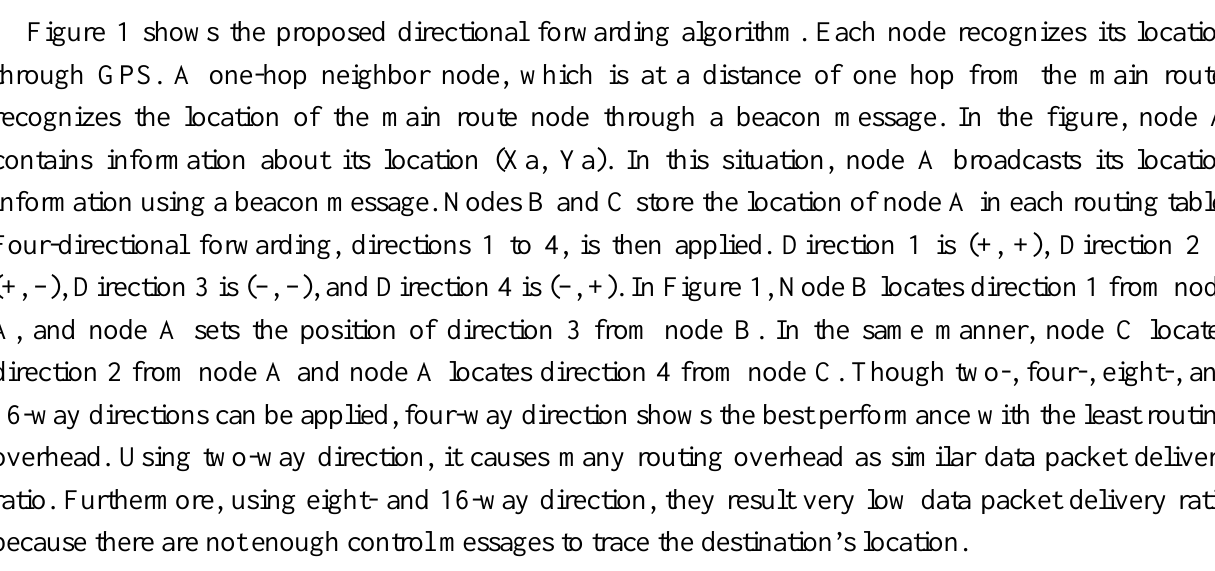
Figure 1. Four-way directional